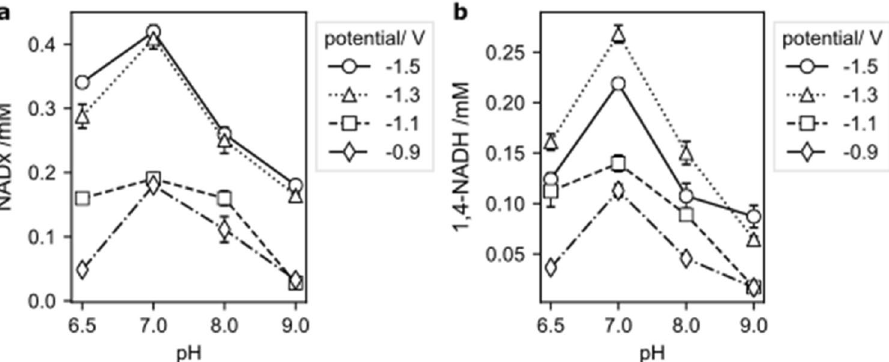
Figure 6. Moles of reaction products after 30 min of NAD + reduction depending on the electrode potential for different pH. ( a ) NADx (NADH isomers and NAD 2 ); ( b ) 1,4